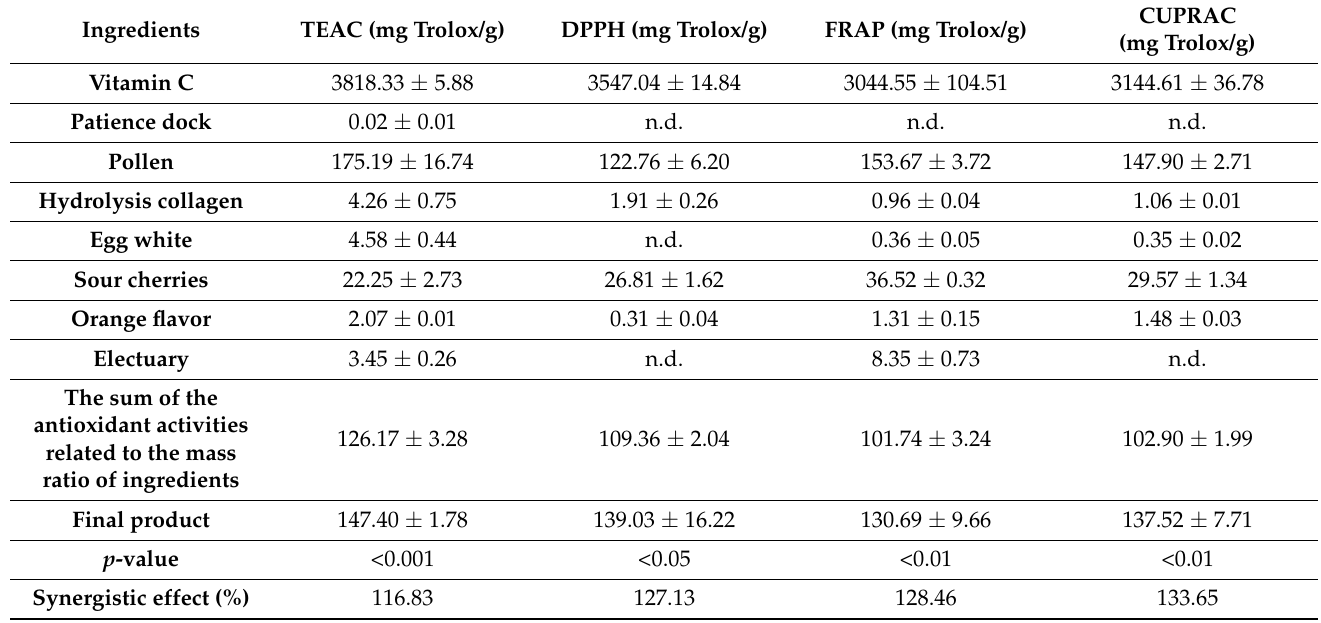
Table 4. Antioxidant activity of ingredients and final product.